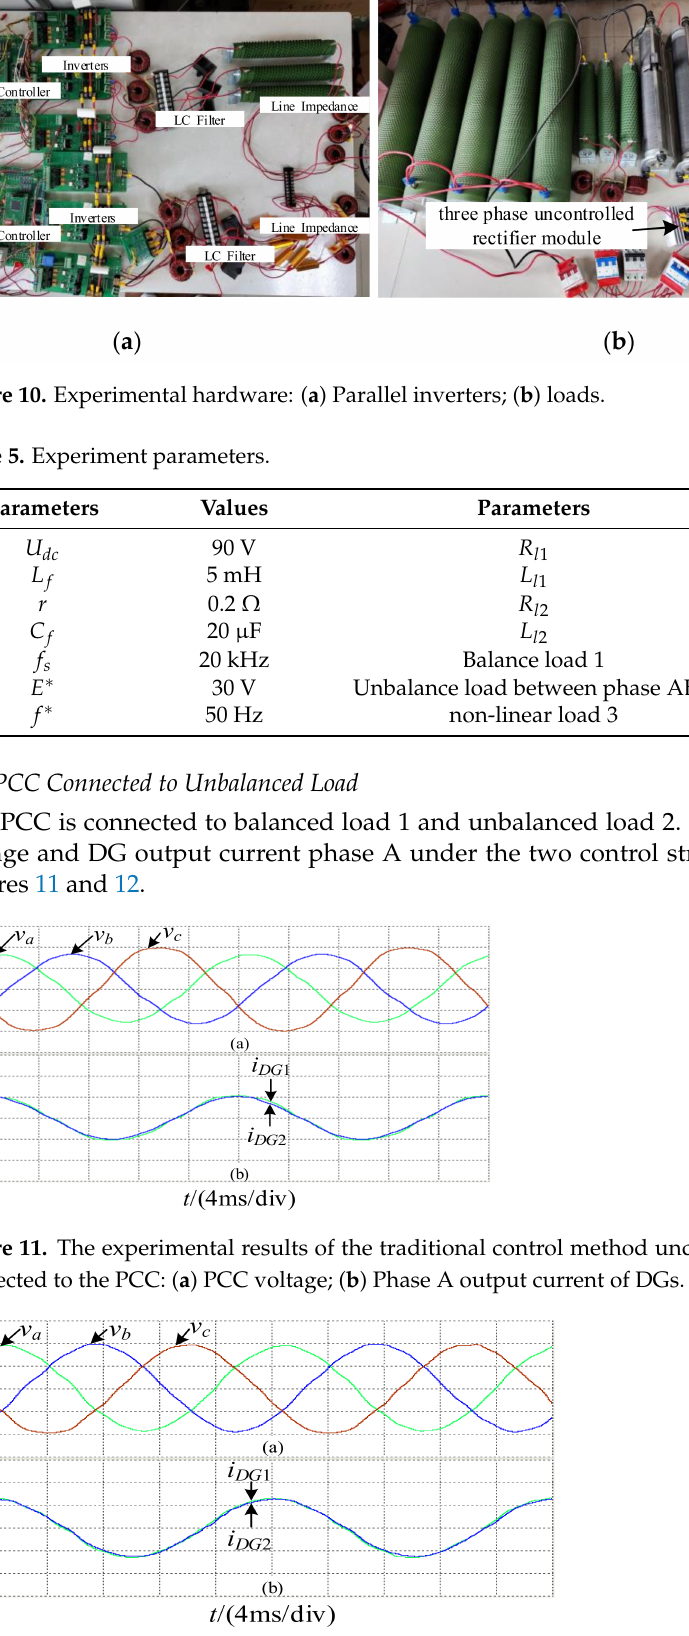
Figure 12. The experimental results of the method proposed under unbalanced load connected to PCC: ( a ) PCC voltage; ( b ) Phase A output current of